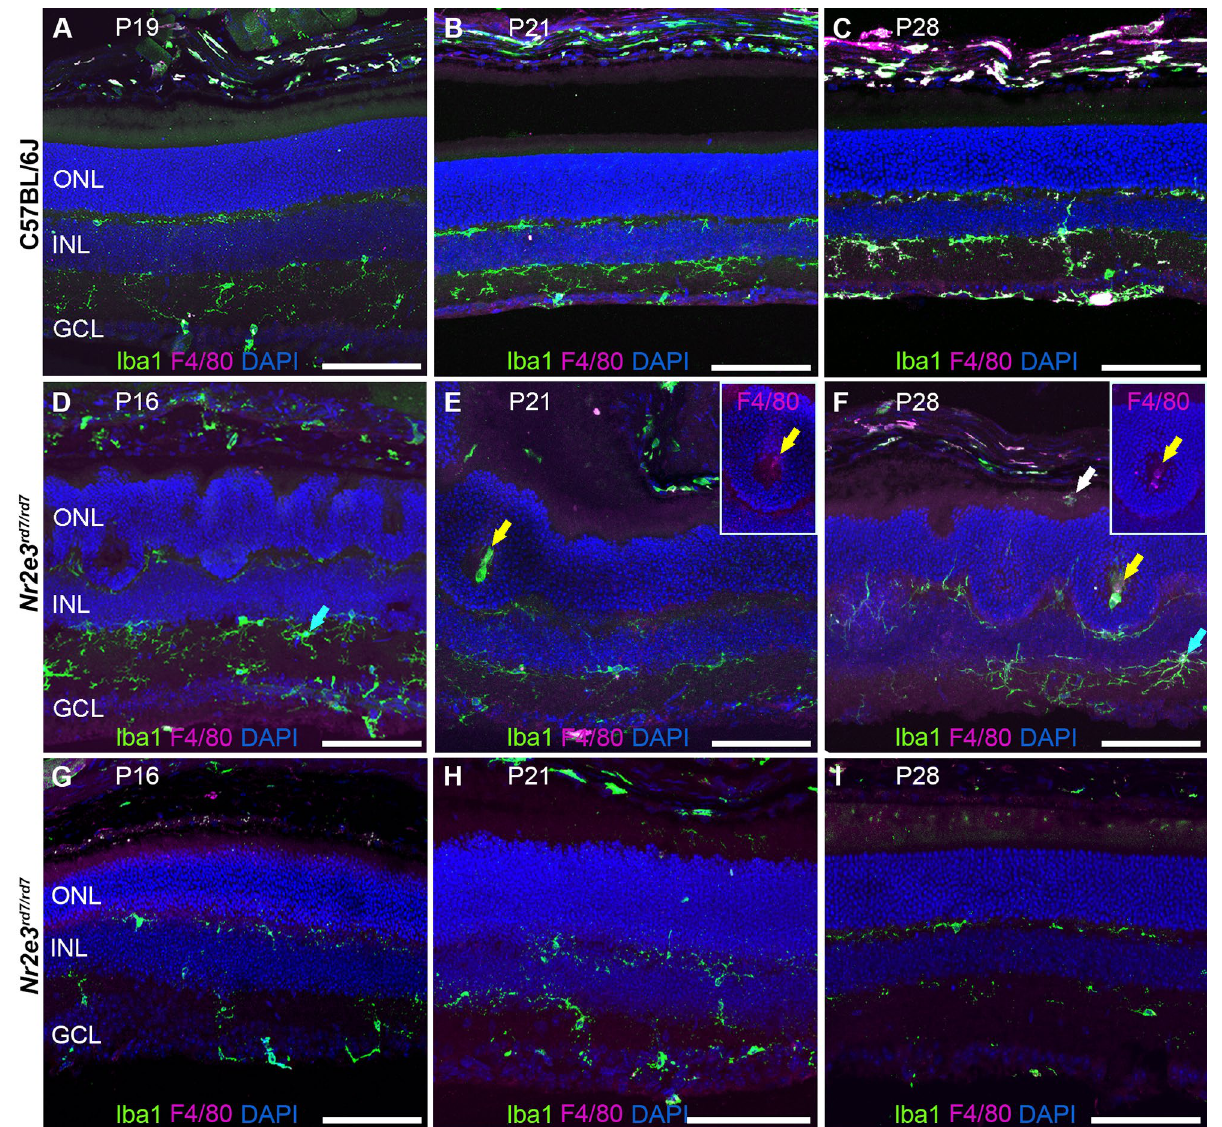
Figure 2. Presence of Iba1 expressing cells inside the rosettes in early postnatal C57BL/6J Nr2e3 rd7/rd7 retinas. Iba1 and F4/80 antigen staining on C57BL/6J retinas at P19 ( A ), P21 ( B ) and P28 ( C ), and on C57BL/6J Nr2e3 rd7/rd7 retinas at P16 ( D , G ), P21 ( E , H ) and P28 ( F , I ). All sections are counterstained with DAPI to visualize cell nuclei. In C57BL/6J Nr2e3 rd7/rd7 retinas at P21 ( E ), Iba1 expressing cells accumulate inside ‘rosettes’ (yellow arrow), where F4/80 expression is faint (insert, yellow arrow). At P28 ( F ), F4/80 expressing cells are present in the subretinal space (white arrow), and a speckle-like F4/80 staining observed inside ‘rosettes’. Activated microglial cells (blue arrows) are present in the inner plexiform layer from P16 ( D ) to P28 ( F ), but not in peripheral regions devoid of ‘rosettes’ ( G , H , I ). ONL: outer nuclear layer; INL: inner nuclear layer. GCL: ganglion cell layer. Scale bars: 100